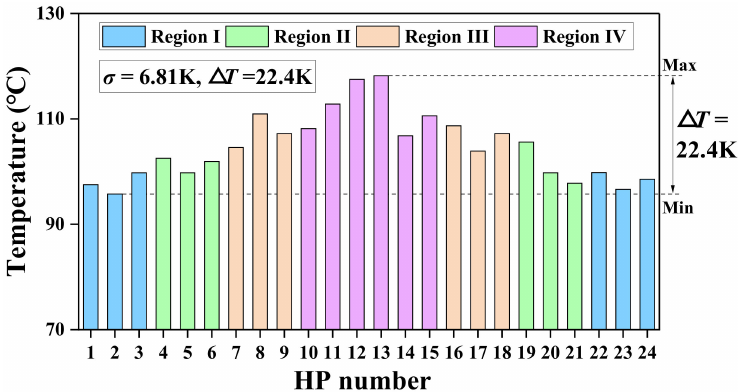
Figure 9. Winding temperature distribution under a current density of 20.6 A/mm 2 and wind velocity of 2.2 m/s.